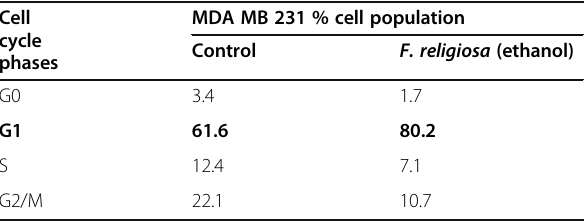
Table 5 The % cell population of MDA MB 231 cells at different phases of cell